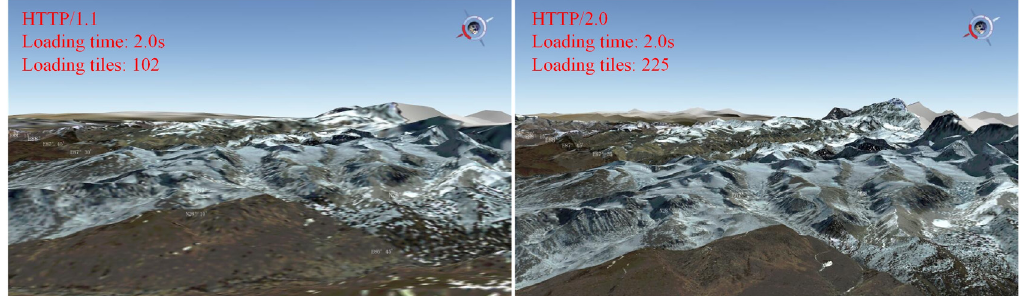
Figure 14. Comparison of tile loading using two different methods.